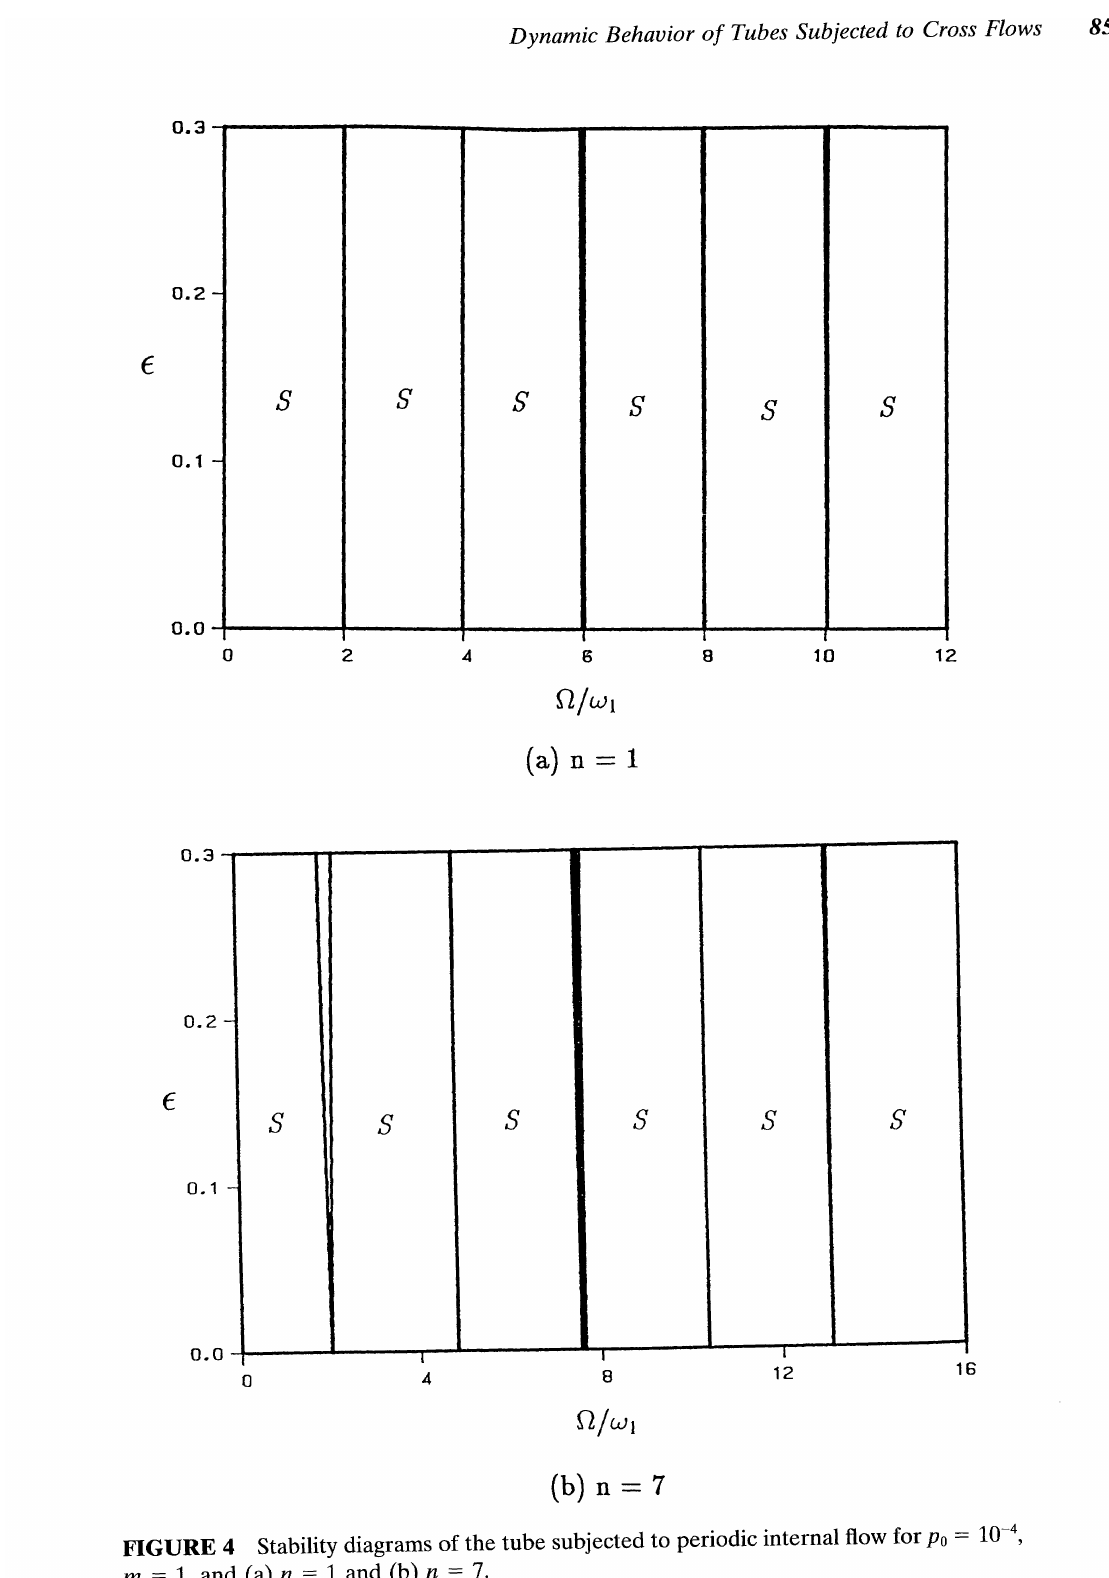
FIGURE 4 Stability diagrams of the tube subjected to periodic internal flow for Po = 10- 4 , m = 1, and (a) n = 1 and (b) n =